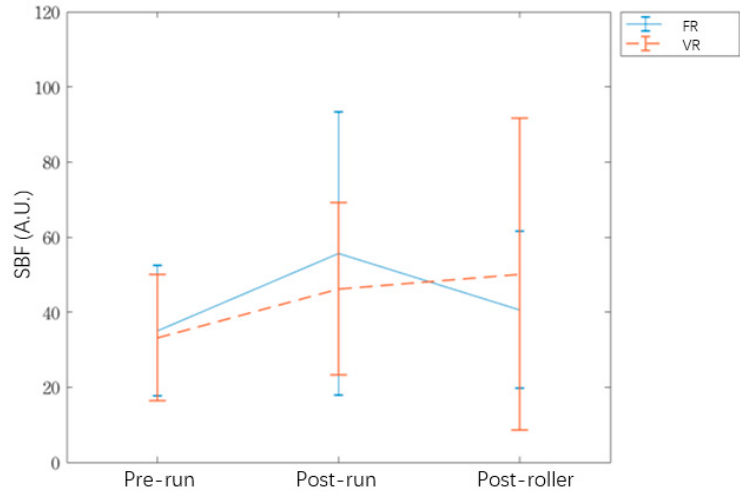
Figure 6. The SBF trend between prerun, postrun, and post-roller. Table 3. Two-way ANOVA analysis of SBF and normalized energy of BFO.